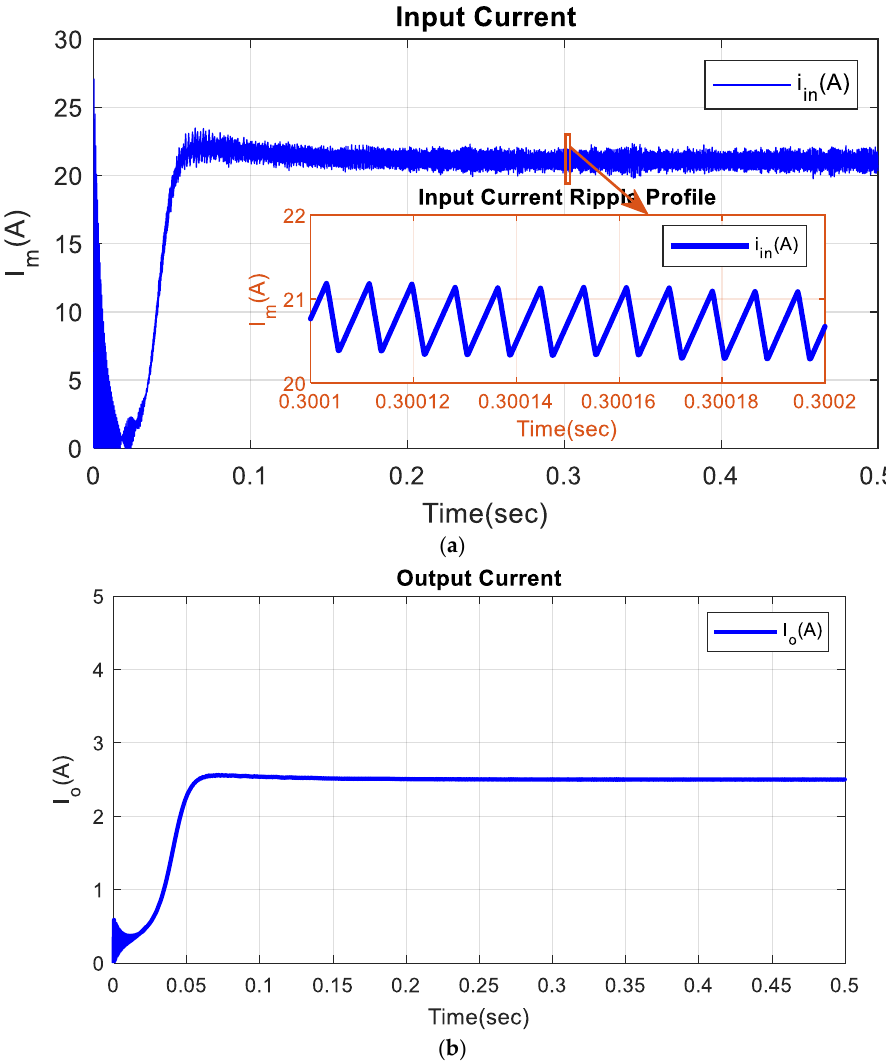
Figure 13. ( a ) Input and ( b ) output currents in the converter.